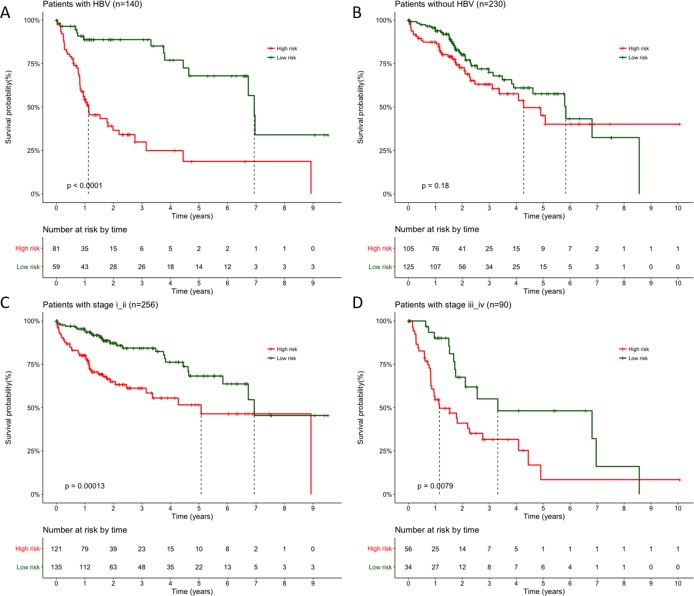
Stratification survival analysis for patients with available HBV infection and pathological information.(A–B) Stratification analysis of patients with or without HBV infection. (C) Stratification analysis of patients with pathological stage i and ii. (D) Stratification analysis of patients with pathological stage iii and iv. P value were all calculated with two-sided log-rank test.